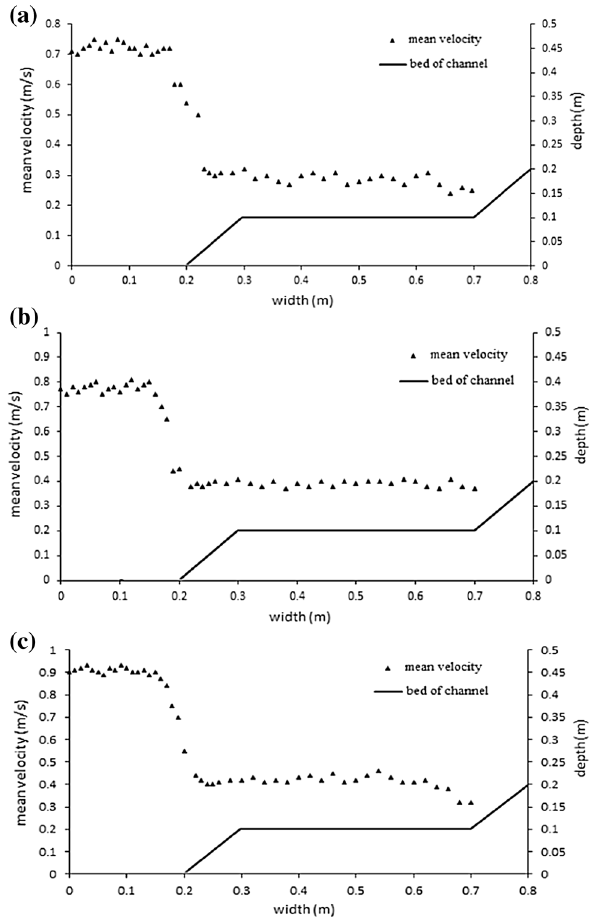
Fig. 5 Comparison of the bed shear stress in smooth and roughened compound channel (roughness distances of 8 k) a Q 1 , b Q 2 and c Q